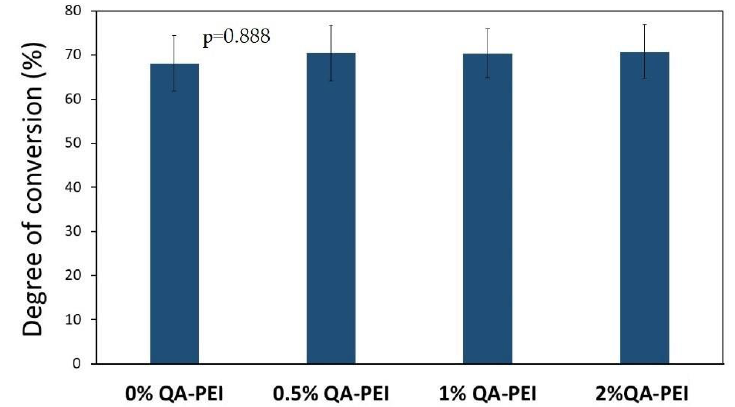
Figure 8. DC values of the materials. All the results for DC were statistically insignificant ( p > 0.05).